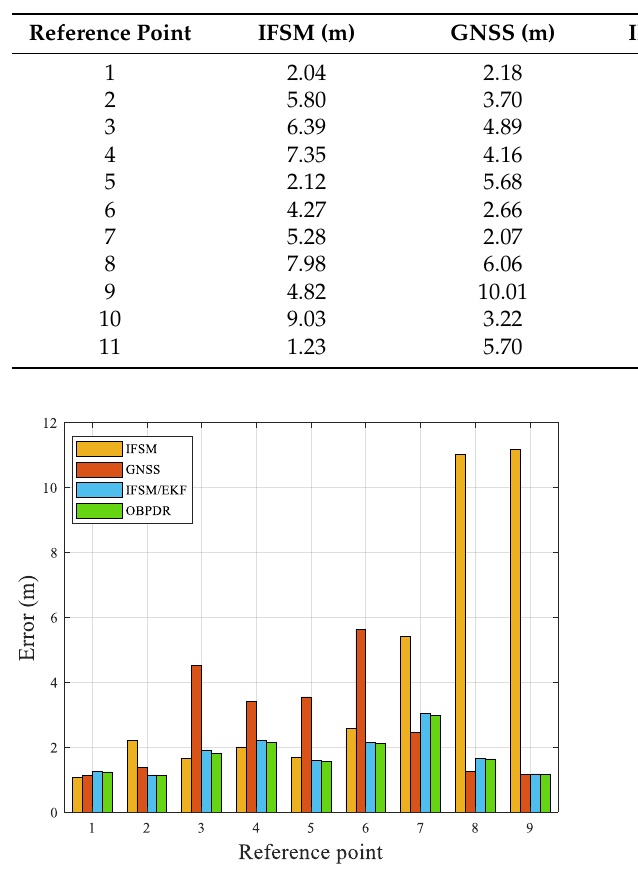
Figure 18. The statistical results of position errors in shadow experiment.